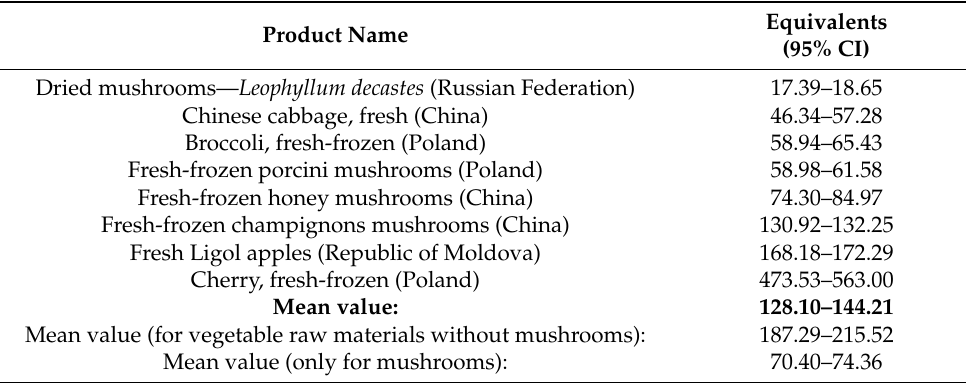
Table 5. ARP values for plant raw materials (combined table, without division into